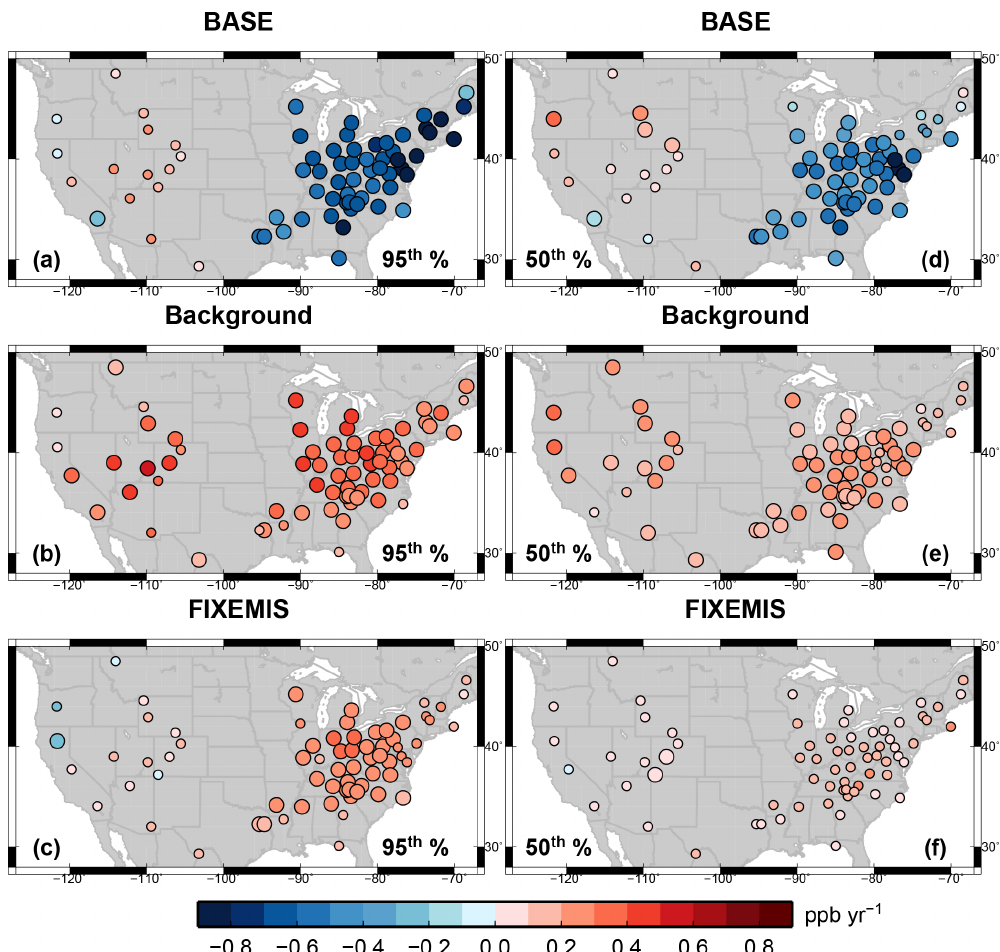
Figure 11. As in Fig. 10, but for summer. Top panels are repeated from Fig. 8d, e.